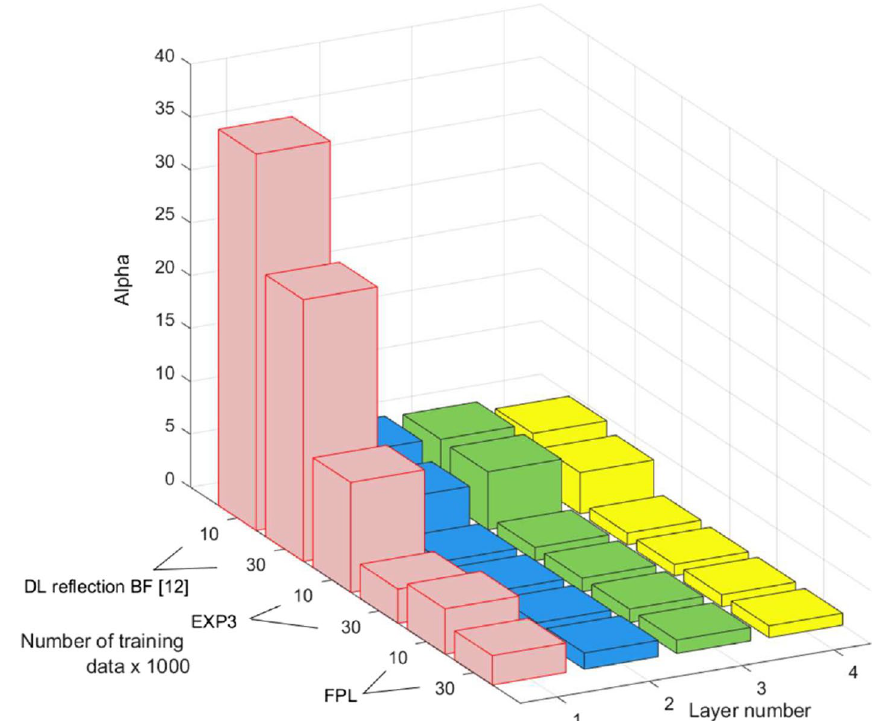
Fig. 8 The power low (PL) exponent α to compare the quality of the models used in the reference method [26], EXP3 and FLP